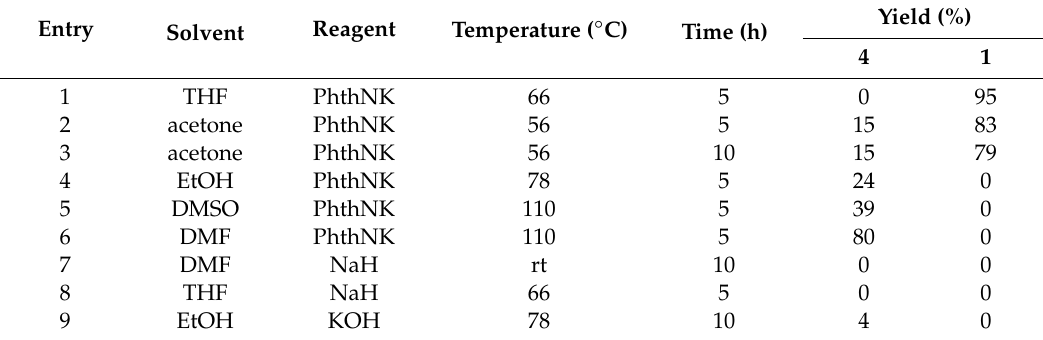
Table 1. Reaction of 2-(chloromethyl)-4 H -3λ 2 -thieno[3,2- d ]pyrimidin-4-one ( 1 ) with basic agents.